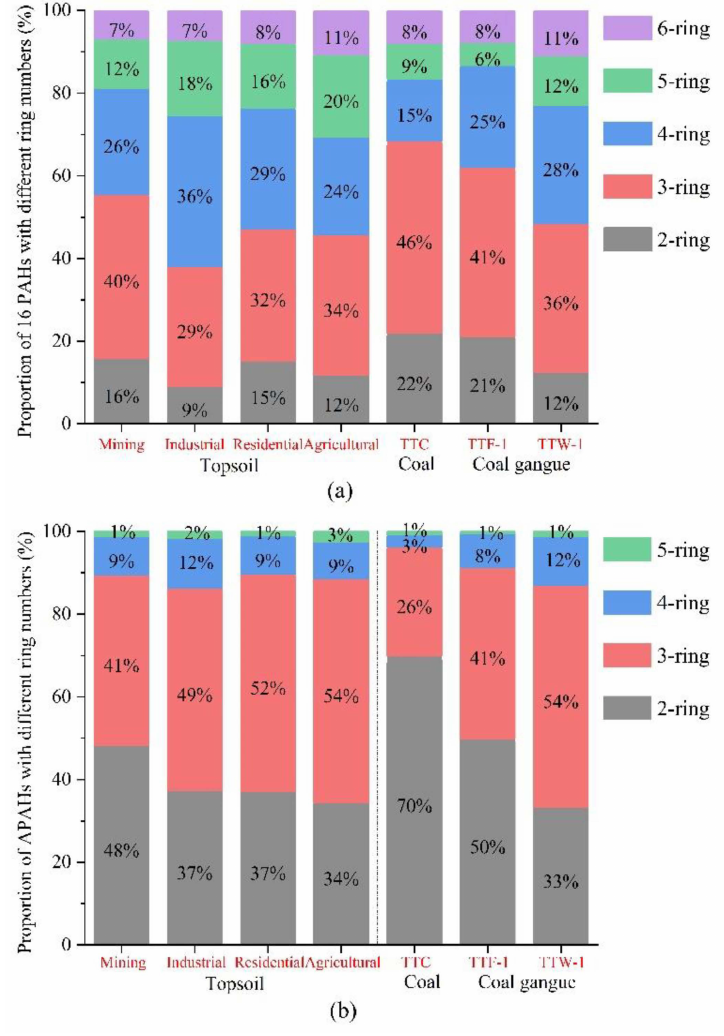
Figure 3. Percentage distribution of 16 PAHs ( a ) and APAHs ( b ) with different ring numbers from topsoil, coal, and coal